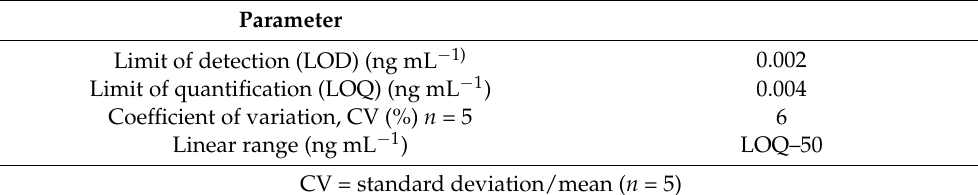
Table 1. Analytical parameters of the QD-based immunoassay for AFM1 quantification.